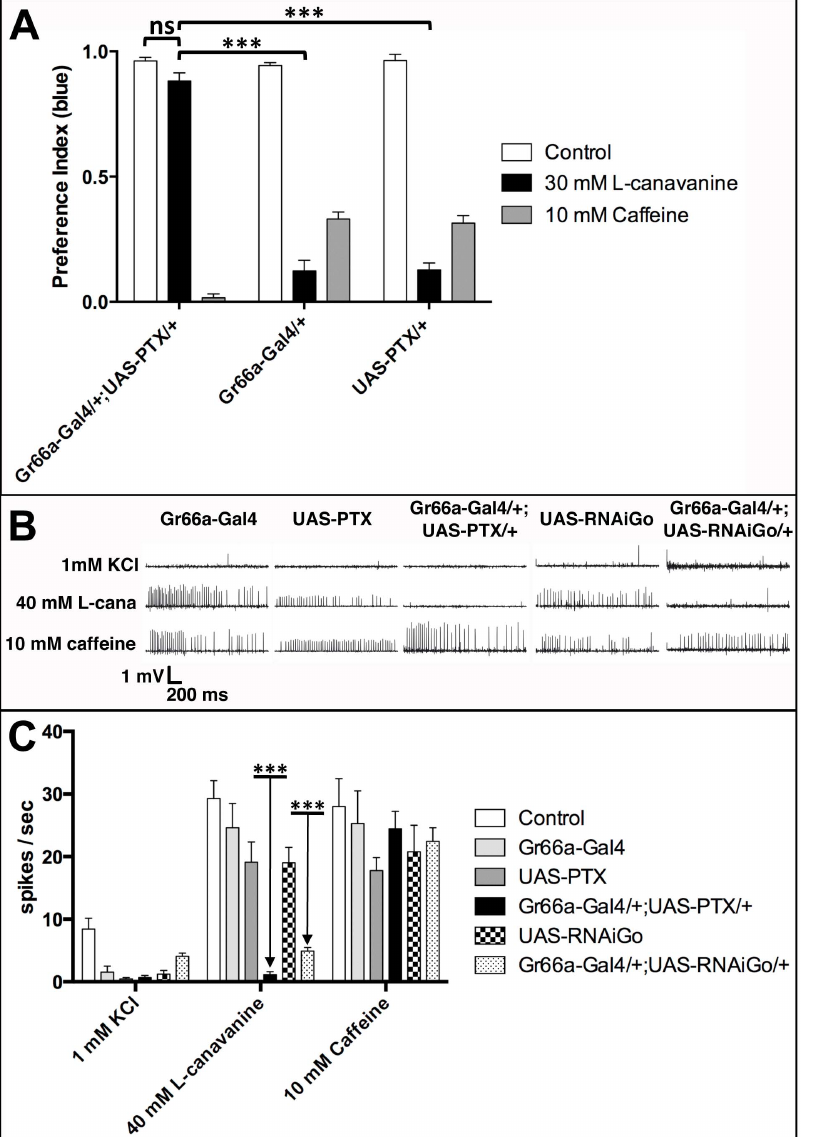
Figure 5. PTX inhibition of G a o47A in bitter-sensitive taste neurons highly reduces L-canavanine aversion and L-canavanine- induced nerve firings, but has no effect on caffeine aversion. A) Two-choice feeding test experiments showing preference index for the blue solution of flies with different genotypes. Control indicates that no drug was added to the blue medium (white bars). Data obtained by using 30 mM L-canavanine in the blue medium are shown in black bars. The expression of a selective toxin (pertussis toxin, PTX) for G a o47A in Gr66a-positive taste neurons (Gr66a-Gal4/ + ;UAS-PTX/ + ) highly reduces the aversion to L-canavanine compared to controls (Gr66a-Gal4/ + and UAS-PTX/ + ). Gr66a-Gal4/ + ;UAS-PTX/ + did not distinguish the control and the L-canavanine containing solutions (ns, p=0.0526). Note that Gr66a-Gal4/ + ;UAS-PTX/ + flies are more sensitive to caffeine (grey bar) than the Gr66a-Gal4/ + and UAS-PTX/ + control lines (p , 0.001). Error bars indicate SEM. Asterisks indicate significant differences by Unpaired Student’s t test (ns: not significant, *** p , 0.001). B–C) Electrophysiological recordings were performed from s6 sensilla on the proboscis of flies with different genotypes. The electrical activity of the taste neurons was recorded by capping taste sensillum with an electrode containing 1 mM KCl as an electrolyte and the stimulus (40 mM L-canavanine or 10 mM caffeine). B) Sample responses for 1 mM KCl, 40 mM L-canavanine (mentioned as L-cana) and 10 mM caffeine on Gr66a-Gal4,UAS-PTX, Gr66a-Gal4/ + ;UAS-PTX/ + , UAS-RNAiG a o47A and Gr66a- Gal4/ + ;UAS-RNAiG a o47A/ + flies. C) Compared to control (white bars) and parental lines (light grey, dark grey and squared bars), Gr66a-Gal4/ + ;UAS- PTX/ + (black bars) and Gr66a-Gal4/ + ;UAS-RNAiG a o47A/ + (dotted bars) did not respond to 40 mM L-canavanine. Note that the response to 10 mM caffeine is not altered for all genotypes. The response was evaluated by counting the number of spikes elicited during the first second of the stimulation. N=7–10 for each condition. Error bars indicate SEM. Asterisks indicate significant differences by Unpaired Student’s t test (*** p , 0.001).